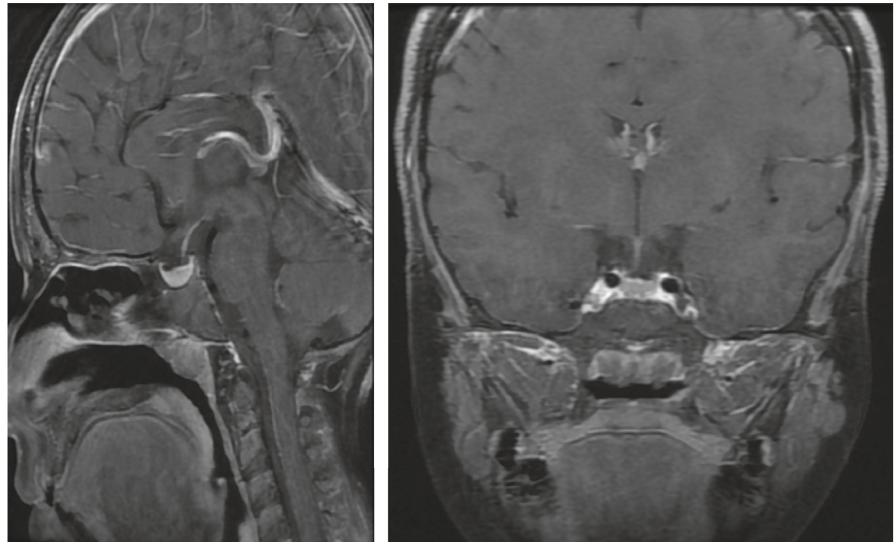
Figure 5: Sagittal and coronal contrast-enhanced T1-weighted magnetic resonance images taken at follow-up after 6 months of thyroid hormone replacement therapy. The images showed a moderate interval reduction in the size of the pituitary mass.